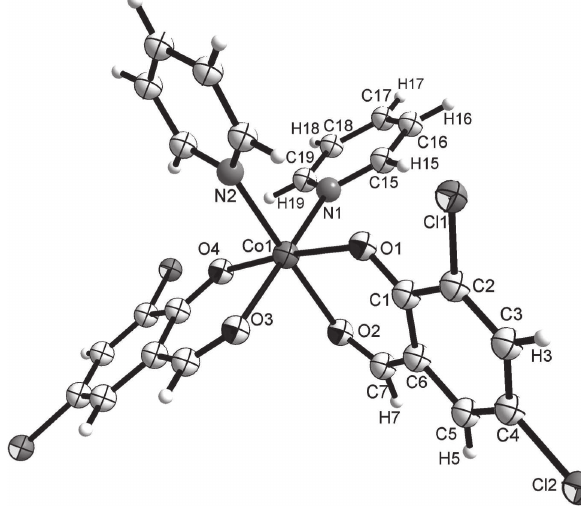
Table 1: Data collection and